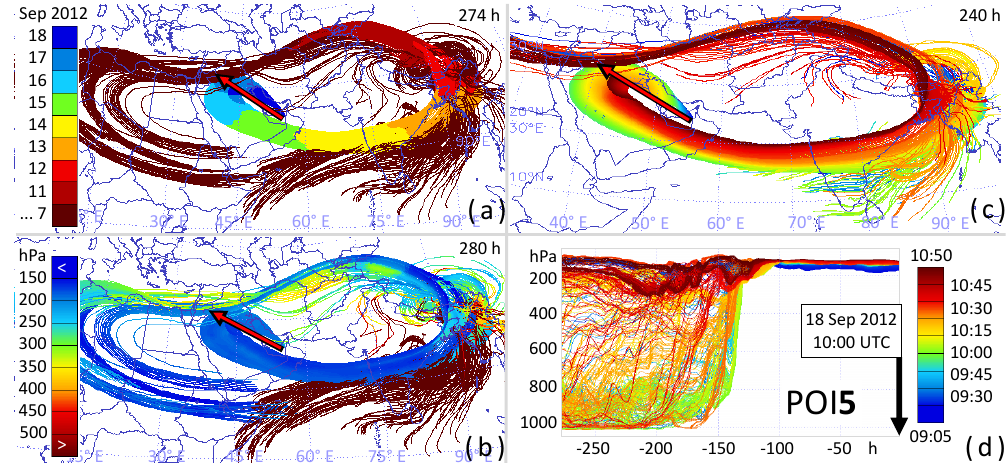
Figure A4. As Fig. 3, but for POI5. This flight segment is dominated by UT ASMA air, entrained by convection.